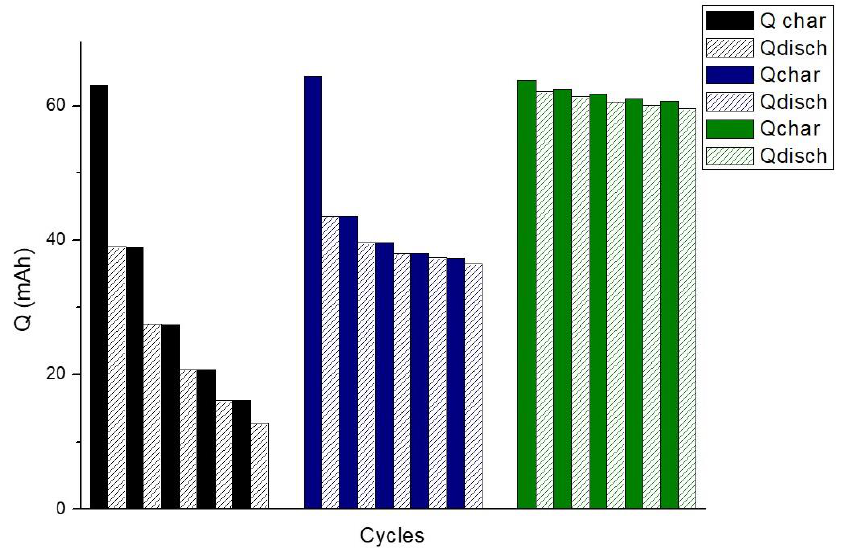
Figure 4. Comparison of the fived first cycles at 20 mA/cm 2 for battery exposed to different concen- trations of O 2 . Black colour: single cell exposed to atmospheric concentrations of oxygen; blue colour: single cell inside a home-made glovebox with concentration of O 2 <2% and green colour: single cell cycle inside a glovebox (<1% O 2 ). Filled columns and dashed column represent charge and discharge capacity, respectively. A total of 0.1 M AQDS in 1 M NaCl vs. 0.1 M Na 4 [Fe(CN) 6 ] in 1 M NaCl was used, using pretreated Nafion 212 ® membrane.